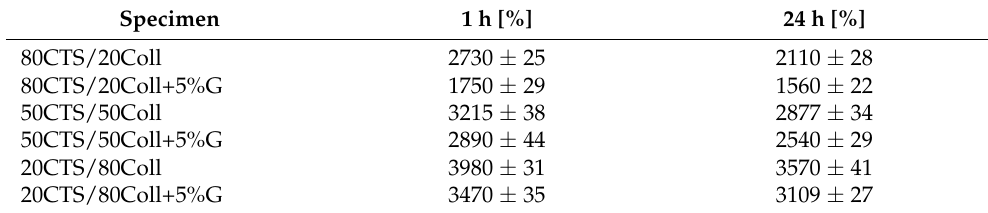
Table 1. The weight change of scaffold after 1 h and 24 h immersion in PBS.